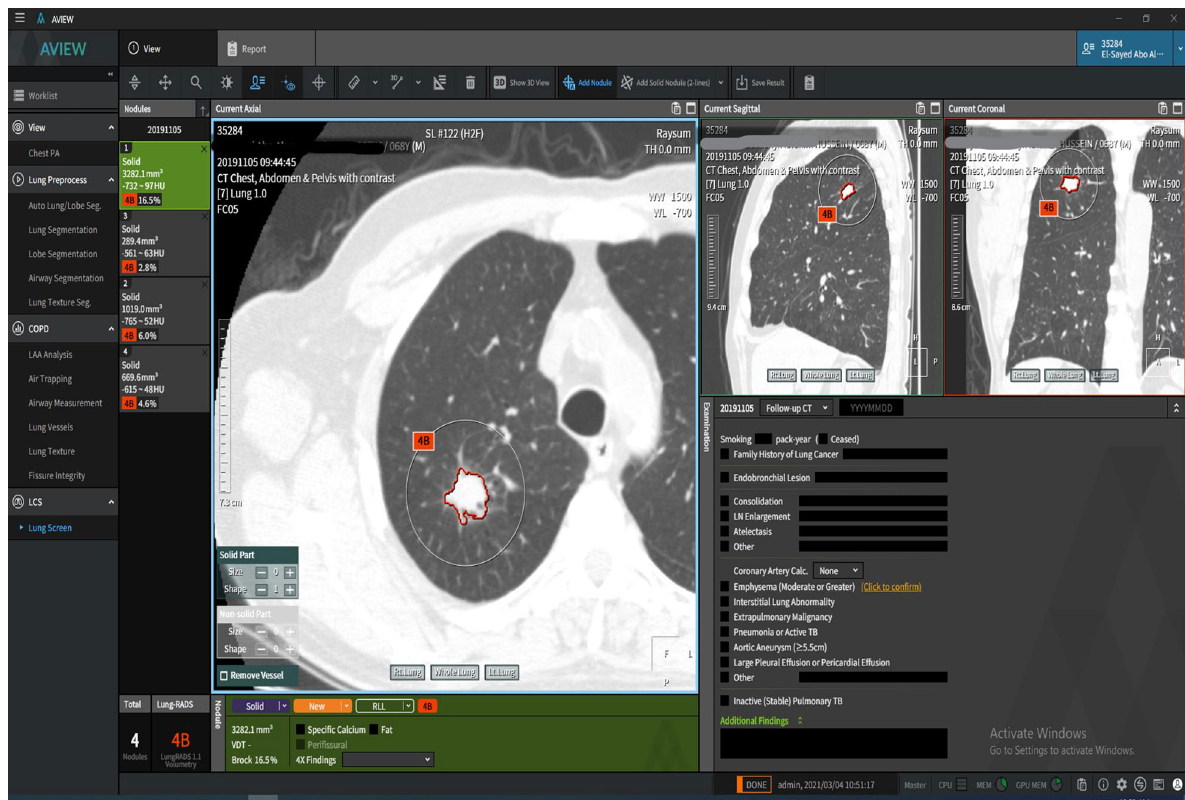
Fig. 3 Four pulmonary nodules were automatically detected by the CAD system and confirmed by the researcher